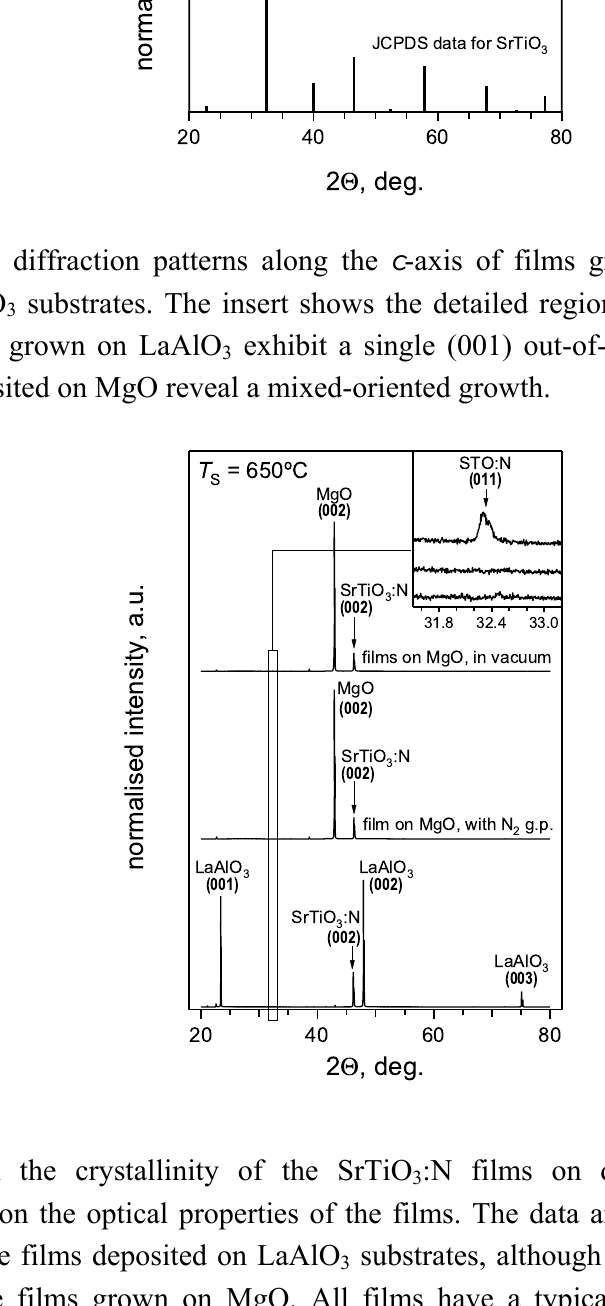
The differences in the crystallinity of the SrTiO :N films on different substrates have no 3 pronounced influence on the optical properties of the films. The data analysis and discussion in this paper is focused on the films deposited on LaAlO substrates, although exactly the same phenomena 3 were observed for the films grown on MgO. All films have a typical thickness of 500 ± 50 nm, allowing a direct comparison of their transmittance